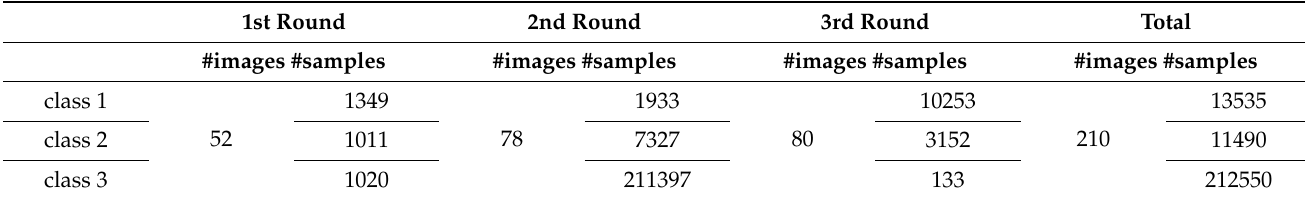
Table 1. Number of images and samples collected in the three rounds of active